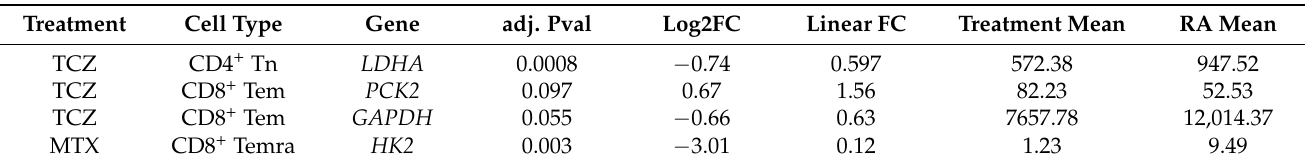
Table 7. Glycolysis/gluconeogenesis pathway DEGs in MTX-, IFX- and TCZ-treated RA T cell subsets. Means are calculated from DESeq2 normalized